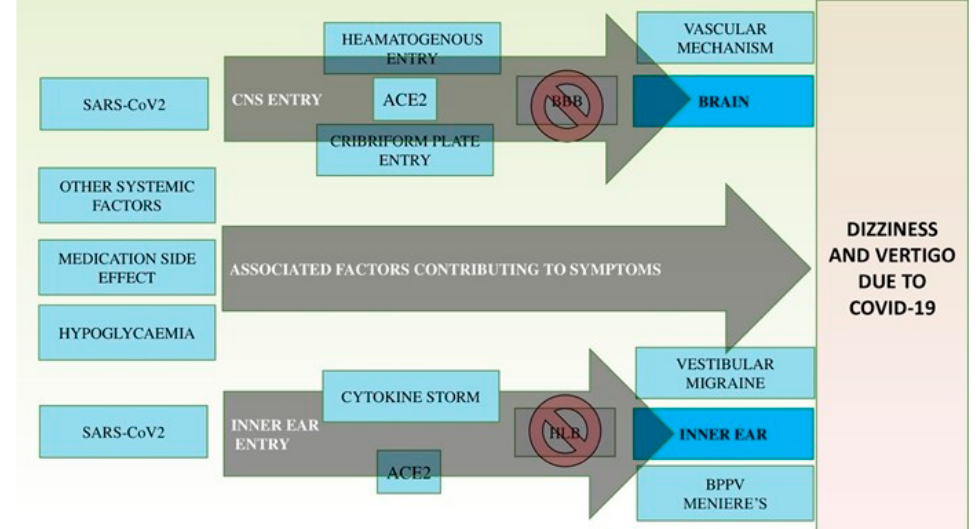
Figure 1. COVID-19 neurotropic and inner ear mechanism of action. SARS-CoV2: severe acute respiratory syndrome coronavirus 2, CNS: Central Nervous System, ACE2: Angiotensin-Converting Enzyme 2, BBB: Blood Brain Barrier, HLB: Hematogenous Labyrinthine Barrier, BPPV: Benign Paroxysmal Positional Vertigo.